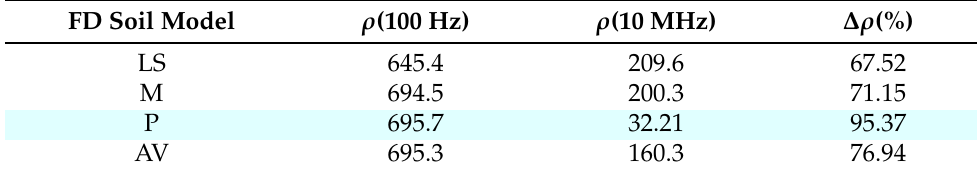
Table 2. ∆ ρ ( % ) for the FD soil models considering the soil of ρ 0 of 700 Ω